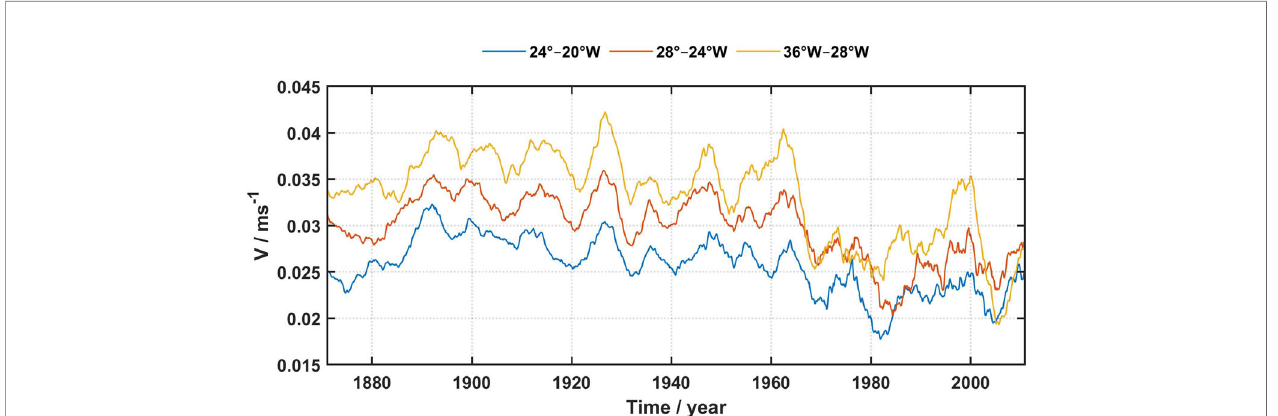
FIGURE 5 | The Azores Current sub-regions. Monthly absolute velocity averaged inside the core of the Azores Current (between 32° and 36°N) in the upper 1000 m between 1871 and 2010. The Azores Current is divided into three sub-regions according to the eddy kinetic energy dynamic at the surface (Barbosa Aguiar et al., 2011; Silva-Fernandes and Peliz, 2020): western (36°W – 28°W, yellow line), central (28°W – 24°W, orange line), and eastern (24°W – 20°W, blue line). All time-series are smoothed with a 60-months running